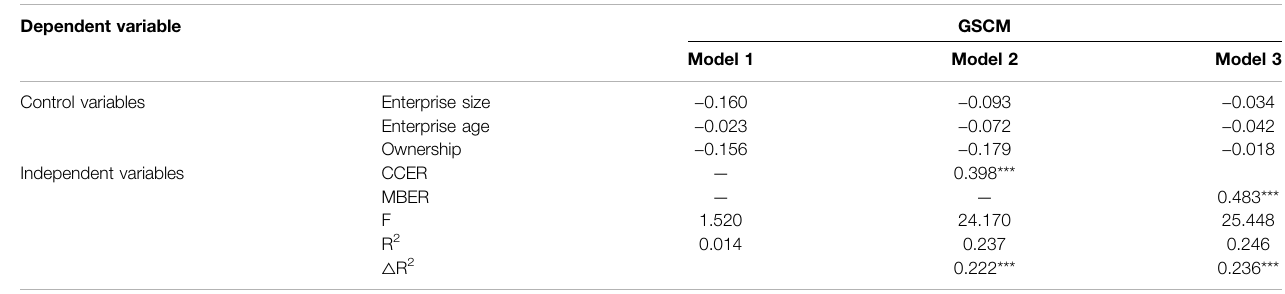
TABLE 6 | Regression analysis results on the direct relationship between ER and